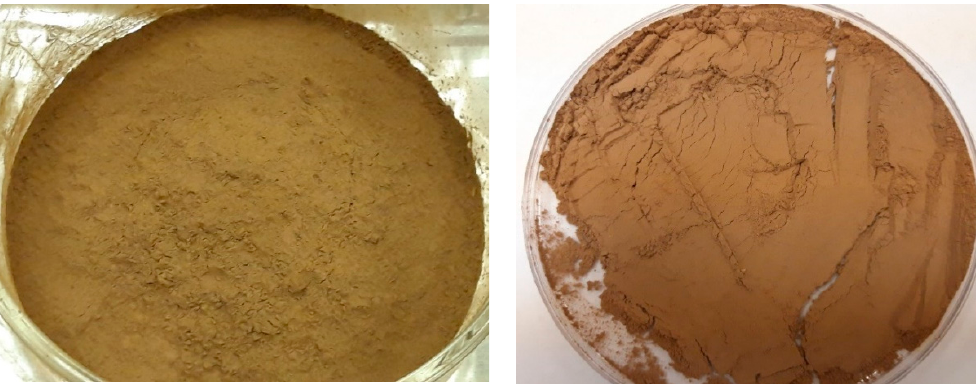
Figure 1. Digital images of date palm nanofiller (DNF).